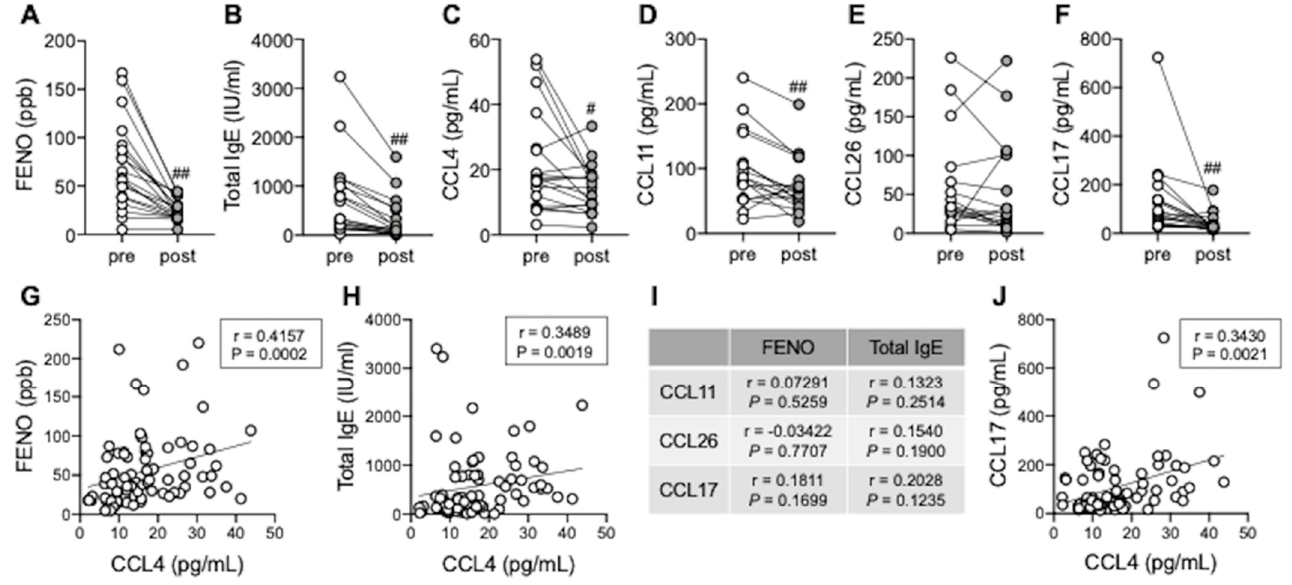
Figure 5. Serum CCL4 levels as a biomarker of type 2 airway inflammation. ( A – F ) FENO ( A ), serum